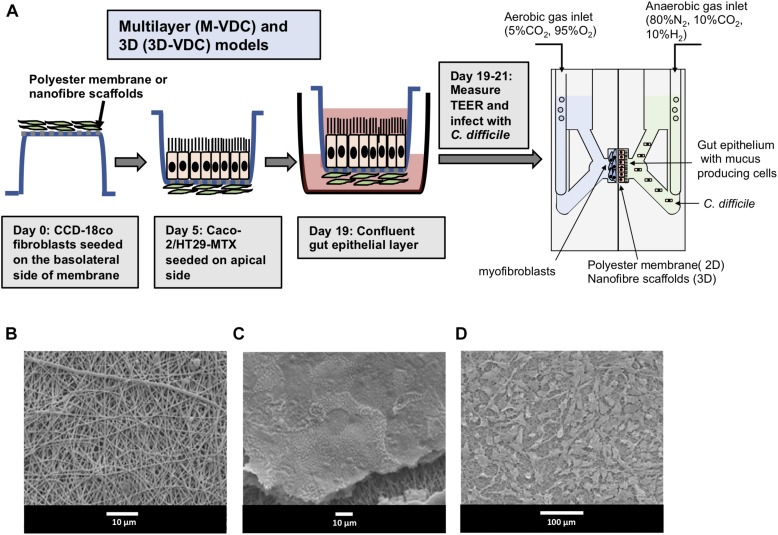
Scheme for generation of multilayer (M-VDC) and 3D (3D-VDC) models containing fibroblast cells and cell growth on the electrospun nanofibrous matrix. (A) Fibroblast cells were first seeded on the basolateral side of the Snapwell or nanofiber scaffold for the M-VDC and 3D-VDC models for 5 days. Thereafter, IECs were cultured on the apical side for 2 weeks before placing the Snapwell insert between two halves of the chamber. C. difficile was infected apically while maintaining anaerobic conditions and the basolateral compartment was perfused with 5% CO2 and 95% air. (B) Polyethylene terephthalate (PET; 10% w/v) was electrospun and exhibited a uniform nanofibrous matrix as determined by scanning electron microscopy. (C) Caco-2 epithelial cells were able to form a confluent monolayer on the nanofibrous scaffolds (the scaffold can be seen underneath the cells following processing for SEM). (D) The CCD-18co cells proliferated across the nanofibrous scaffold forming cell processes to adhere to the nanofibers.